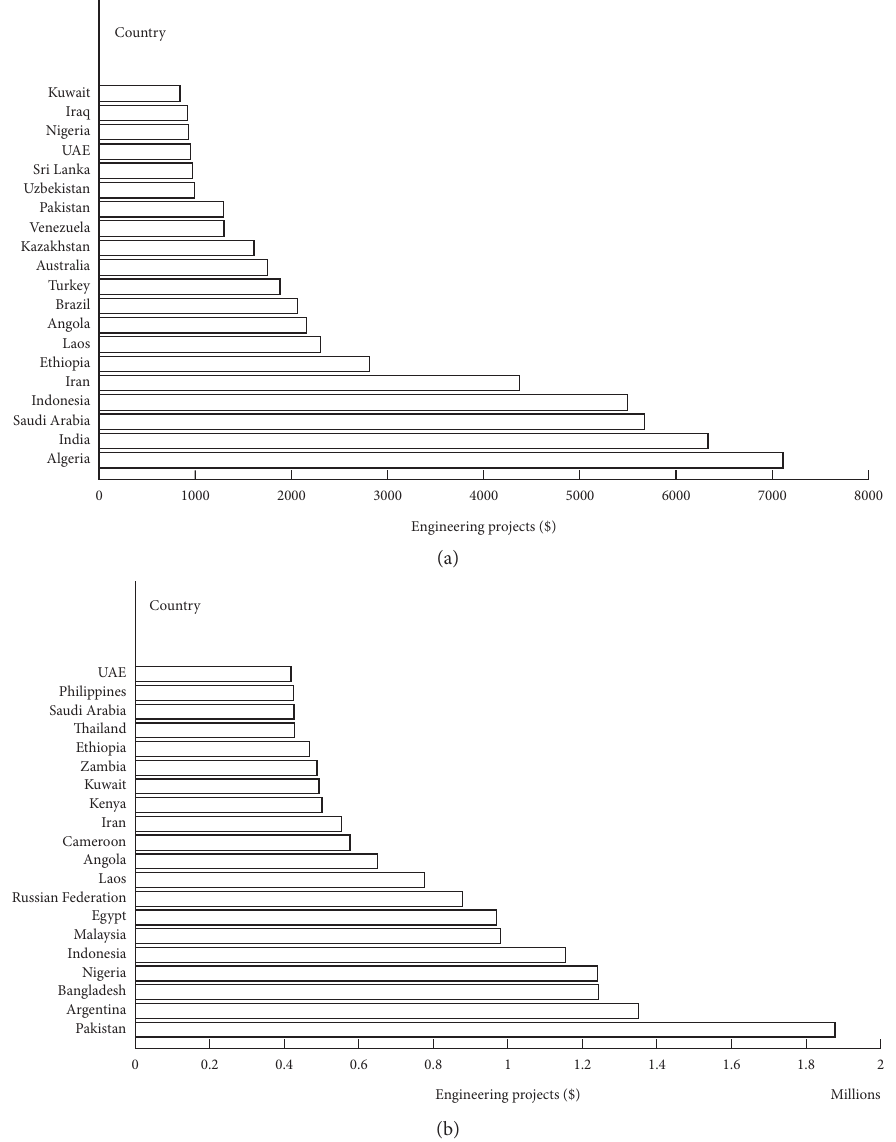
Figure 8: Top 20 IEs of China’s overseas construction projects (E1): (a) 2005–2007; (b)